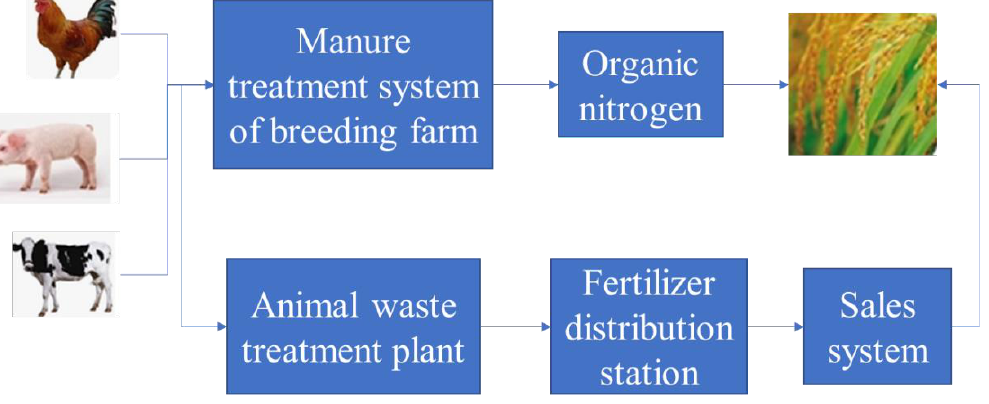
Figure 9. Nitrogen nutrient flow from animals to farmland.